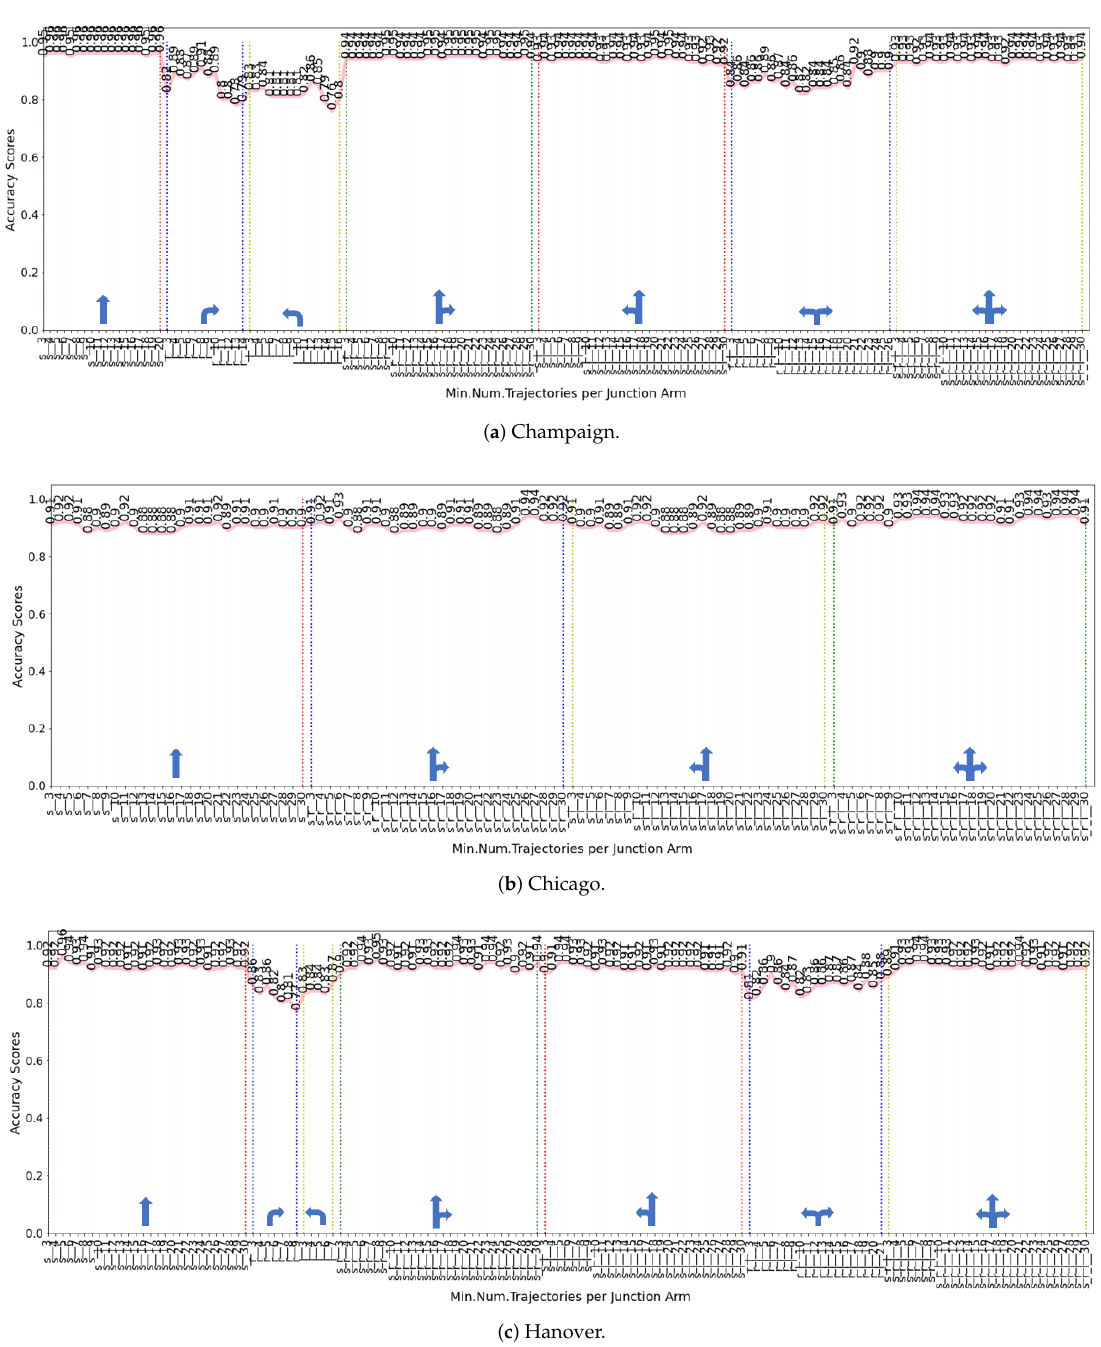
Figure 12. Experiments with different turning settings (s_: straight trajectories, r_: right turning trajectories, l_: left turning, s_r_: straight and right turning, s_l_: straight and left turning, r_l_: right and left turning, s_r_l: straight, right, and left turning trajectories). Regarding the effect of turning trajectories on classification performance, we see that using right, left or right/left traces has lower performance than using straight traces and combinations of straight and turning traces (Figure 12a,c). When using a combination of straight and turning traces, we cannot see a strong negative effect, but this can per- haps be explained by the fact that there are significantly more straight crossings than left and right in the dataset (in Champaign 20,514 straight, 2619 right, and 2768